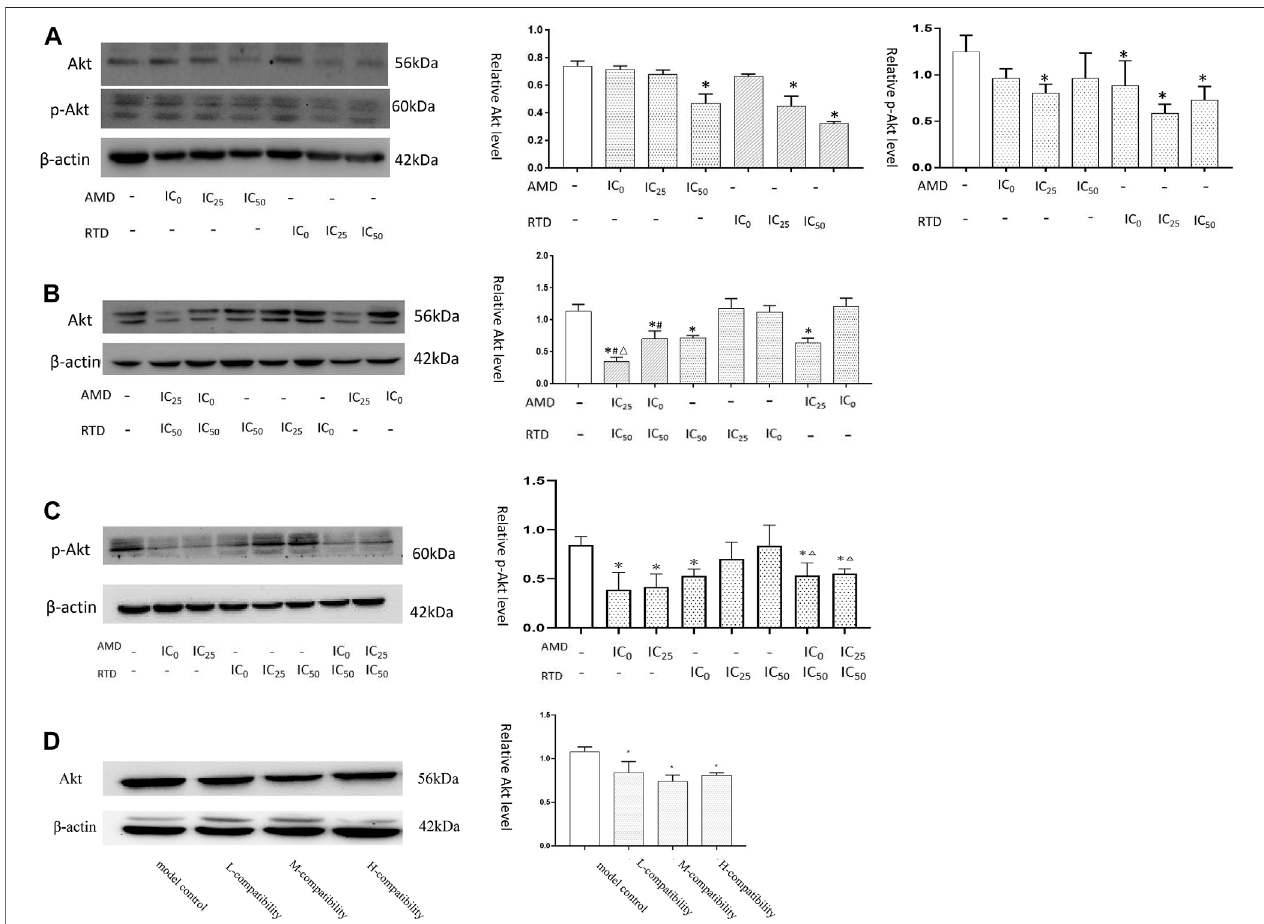
FIGURE9| AMD, RTD,and theircompatibility affectAkt-relatedprotein expression. (A) Western blottinganalysisandrelativequanti fi cation levels ofAktand p-Akt expression of A375 cells with herb treatment for 48 h (A) and 72 h (B) . (C) Western blotting analysis and relative quanti fi cation levels of p-Akt expression of A375 cells withherbtreatmentfor72 h. n =3. p p < 0.05,compared withthecontrolgroup. # p < 0.05,comparedwiththecorrespondingAMDgroup. △ p < 0.05,compared withthe corresponding RTD group. (D) Western blot analysis and relative quanti fi cation levels of Akt expression of the tissues. p p < 0.05, compared with